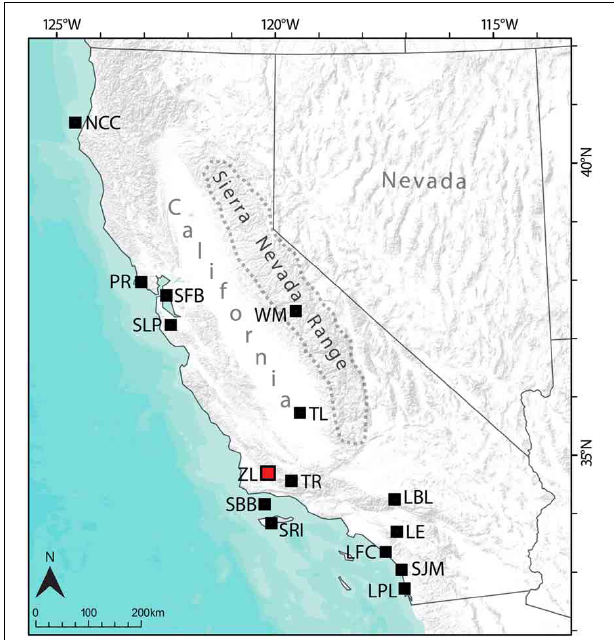
FIGURE 1 | Map of California and Nevada with locations referenced in the text. The geographic extent of the Sierra Nevada Range is marked by the dashed line. Zaca Lake location marked with a red square, other sites referred to in the text marked with black squares. LBL (Lower Bear Lake), LE (Lake Elsinore), LFC (Las Flores Creek), LPL (Los Peñasquitos Lagoon), NCC (North coast California), PR (Point Reyes), SBB (Santa Barbara Basin), SFB (San Francisco Bay), SJM (San Joaquin Marsh), SLP (Skylark Pond), SRI (Santa Rosa Island), TL (Tulare Lake), TR (Transverse Ranges), WM (Wawona